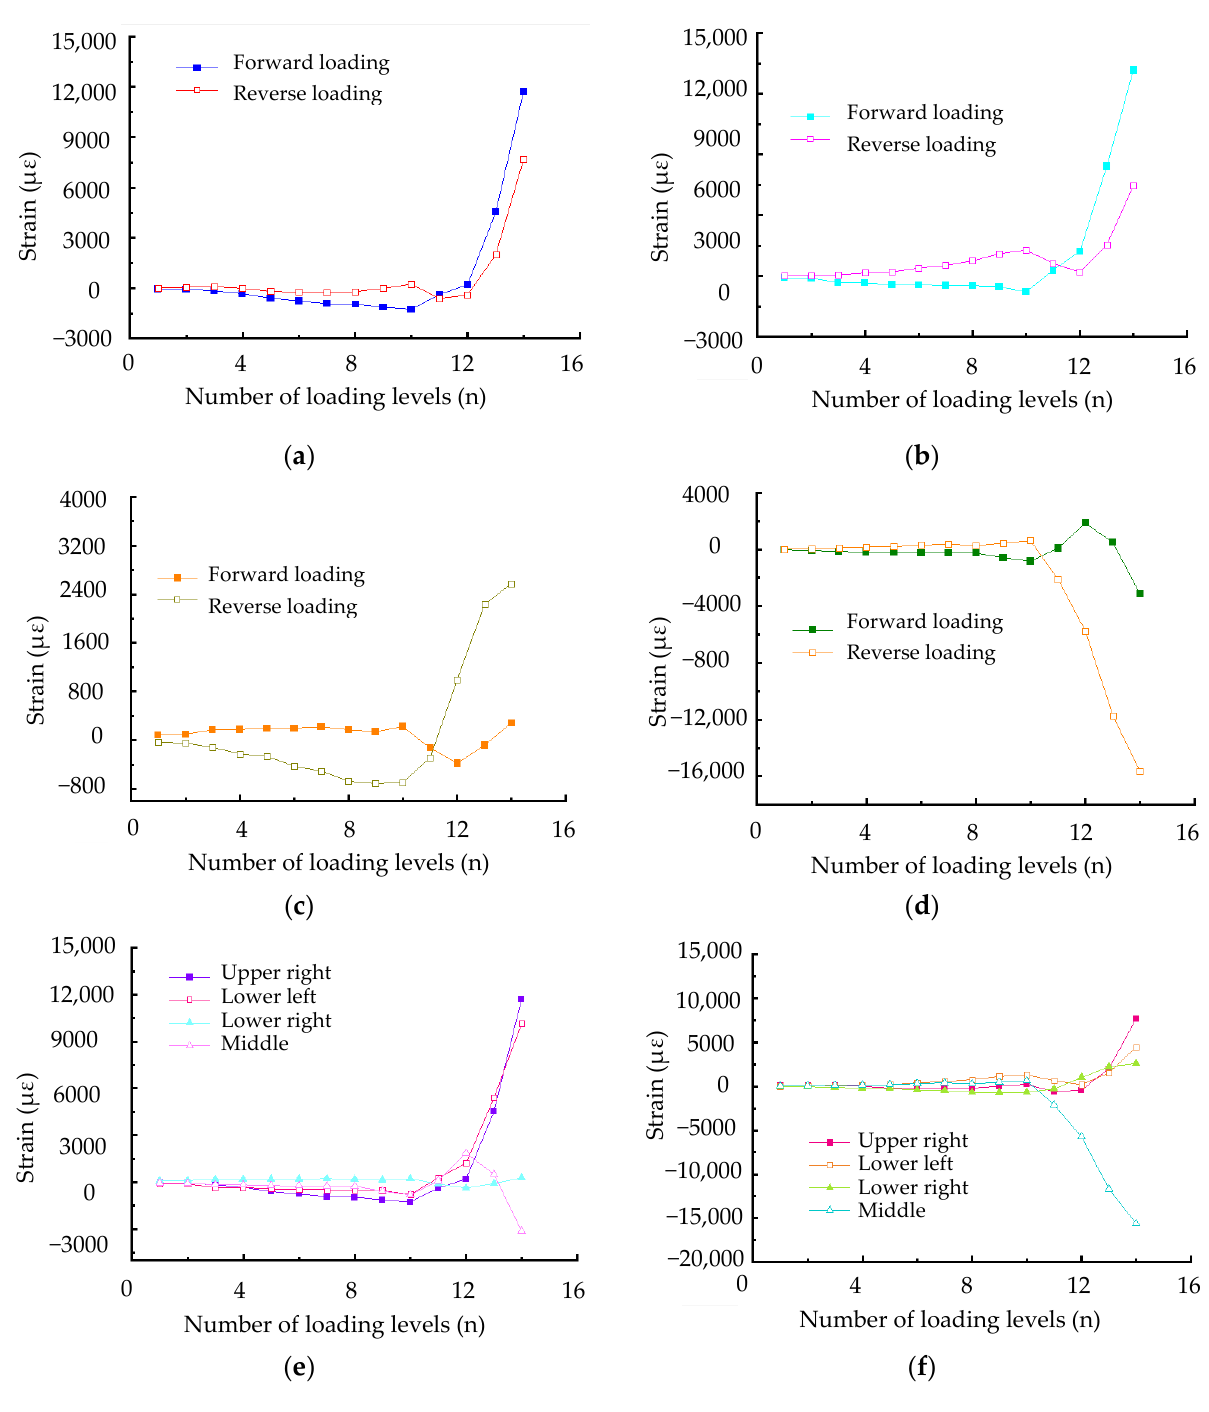
Figure 20. Variations of strains in the infill panel of specimen 1: ( a ) Strains at the upper-right corner of infill panel; ( b ) Strains at the lower-left corner of infill panel; ( c ) Strains at the lower-right corner of infill panel; ( d ) Strains at the middle of infill panel; ( e ) Strains of infill panel during forwarding loading; ( f ) Strains of infill panel during reverse